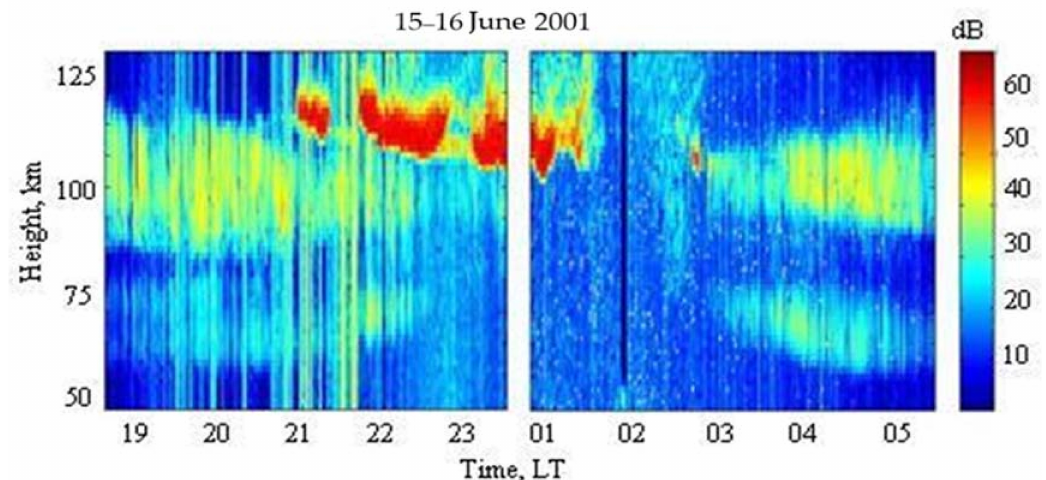
Figure 8. Time-height-amplitude plot of the API scattered signal in sunset-sunrise hours on 15–16 June 2001. The lower boundary of the layer dropped from 113 km to 99